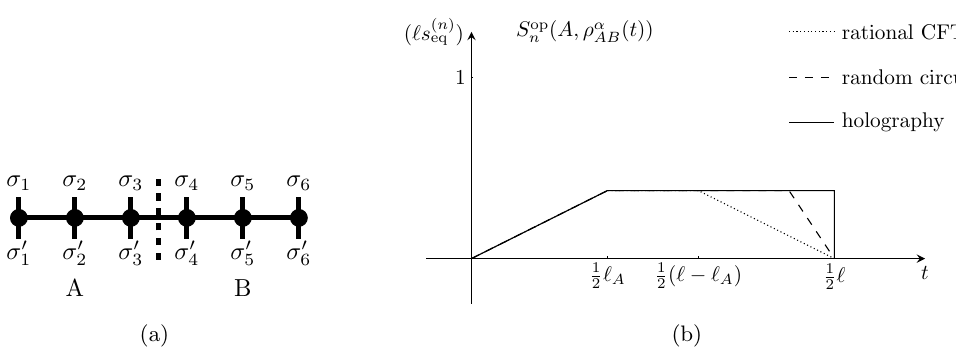
Figure 1 . Operator entanglement of the reduced density matrix. (a) Viewing the reduced density matrix as a matrix product operator. The operator entanglement is roughly logarithm of the bond dimension. The physics indices (cid:27) and (cid:27) 0 are the indices in the operator Hilbert space. (b) The time dependence operator entanglement or reduced density matrix in 3 representative systems. Subsystem A is contiguous and has size ‘ A . Total system has length ‘ . The Entanglement quantities are displayed in units of the corresponding state equilibrium entropy density s ( n ) eq in each system, see section 5 for more detailed